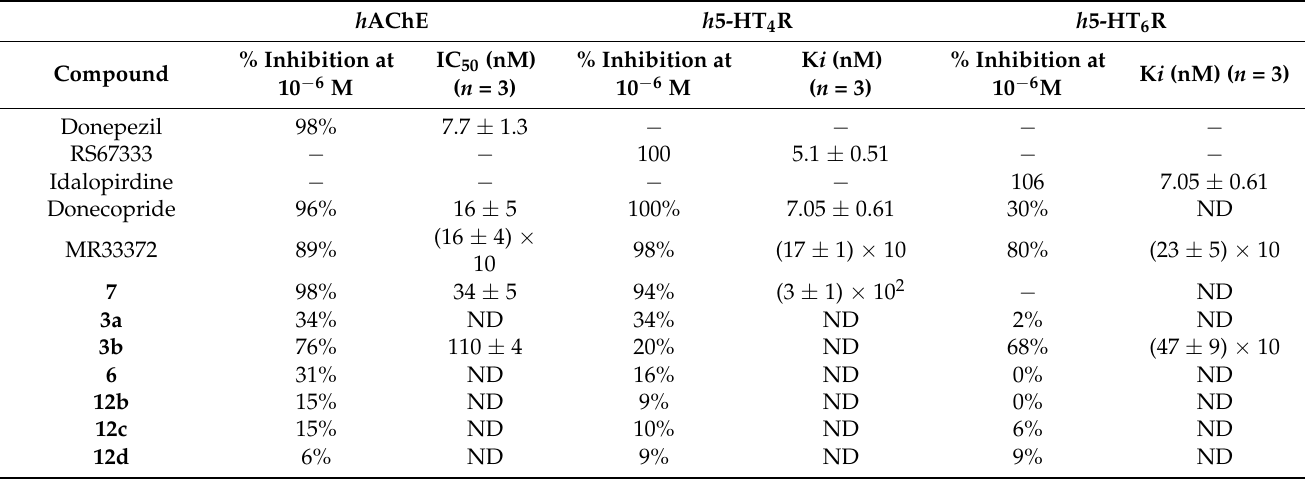
Table 1. h AChE inhibitory activity and affinity for 5-HT 4 R and 5-HT 6